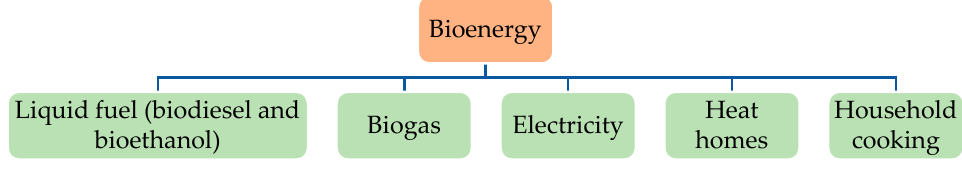
Figure 2. Mainly types of bioenergy.